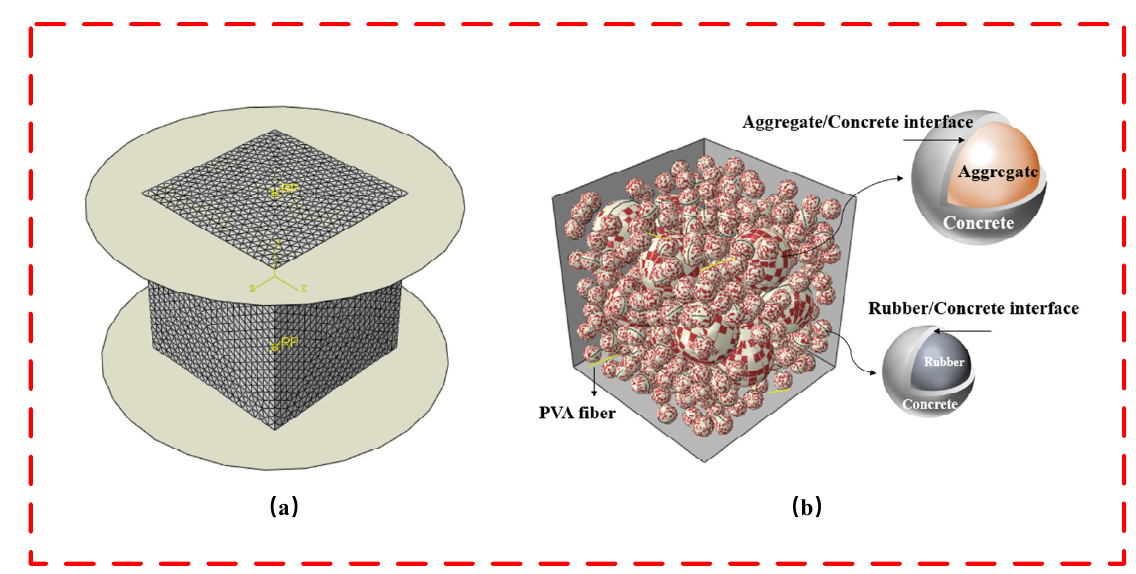
Figure 10. Uniaxial compression 3D mesoscopic model: ( a ) Uniaxial Compression Model; ( b ) 3D Aggregate Spatial Distribution.